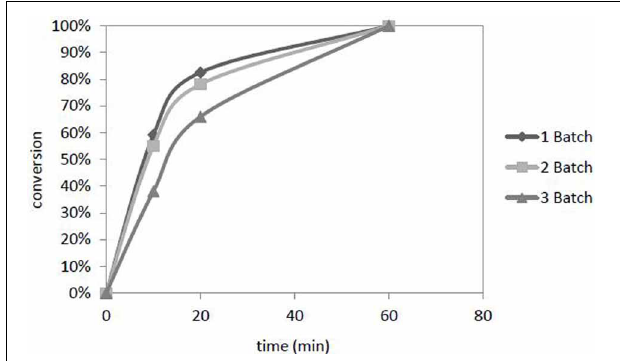
FIGURE 8 | Deactivation of the catalyst Pd in [ADBA][MeO] on ACC during three consecutive experiments. Citral conversion to products is presented as a function of time. The reaction conditions were T = 100 ◦ C, p ( H 2 ) = 10